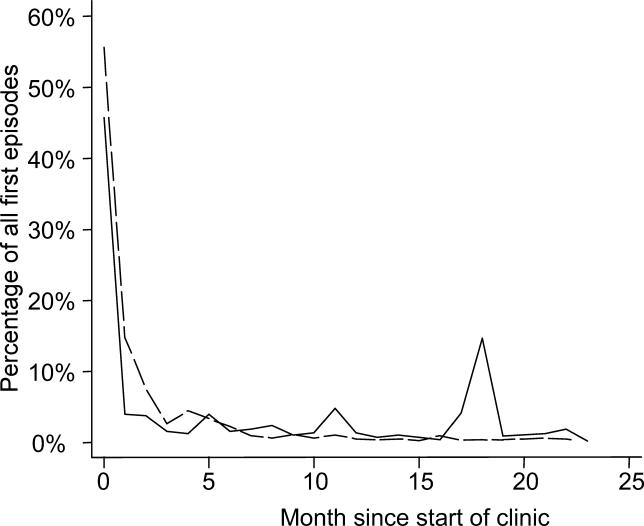
Timing of Uptake among Employees Who Accepted VCT or VouchersBroken line denotes on-site VCT uptake; solid line denotes off-site voucher uptake.